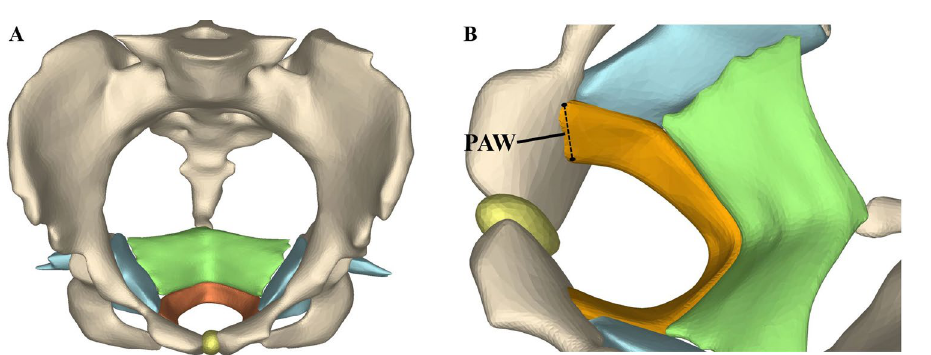
Figure 2. Parasagittal view of the puborectalis attached to the pubic ramus. ( A ) presented the schematic drawing of the principal structures of the attachment, which was seen in ( B ). ( B ) Showed the intact attachment of the puborectalis, with the hyperechogenic muscle fibers clearly visible. The black dotted line showed the measurement of the puborectalis attachment width (PAW). ( C ) Showed the partial avulsion of puborectalis at the attachment. ( D ) Presented the complete avulsion of puborectalis.